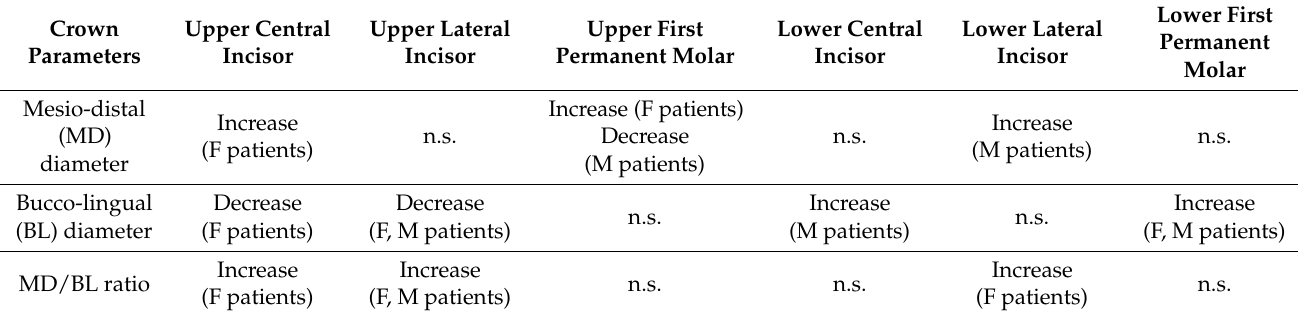
Table 10. Statistically significant differences in crown parameters between patients with crowded arches and patients with normally aligned arches in the study group according to ANOVA and post hoc Bonferroni analysis. Crown Upper Central Parameters